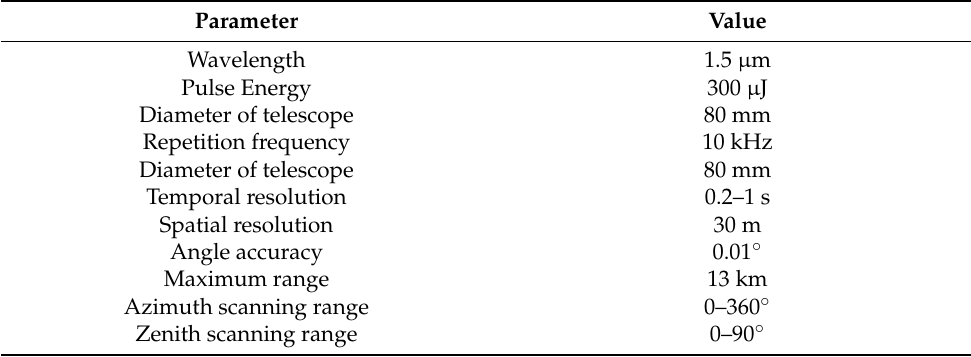
Figure 2. ( a ) The location of the CDWL at BDIA, ( b ) Photograph of the CDWL. Table 1. Key Parameters of the CDWL.